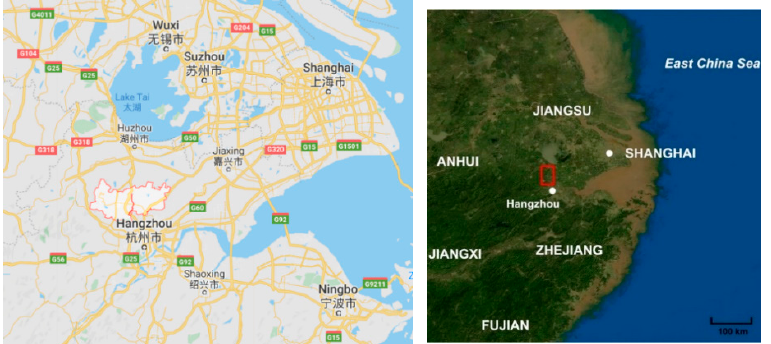
Figure 2. Geographical location of Deqing County (extracted from Google Maps).